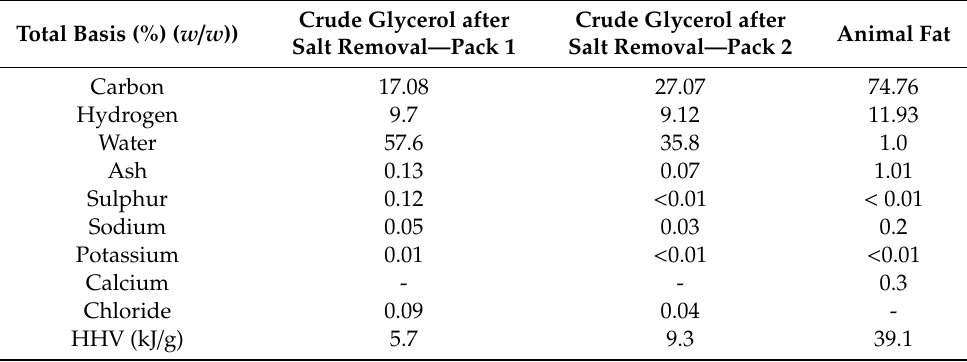
Table 1. Crude glycerol and animal fat